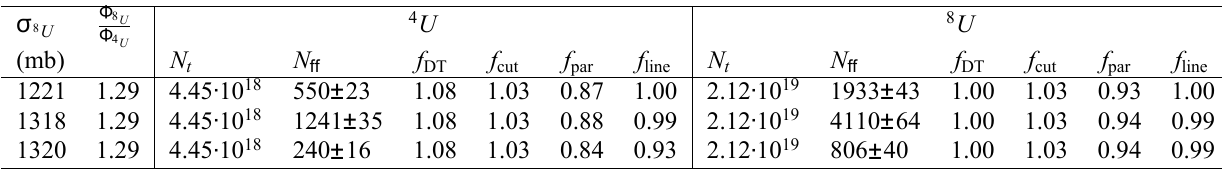
Table 2. All the quantities of Eq. 1. The first row corresponds to the quantities referred to the irradiation at 14.8 MeV, the second one at 16.5 MeV and the third one at 17.8 MeV. The f abs factor for the ff absorption in the 4 U and 8 U samples was 2 and 1% , respectively. Φ 8 U 4 U σ 8 U Φ 4 U